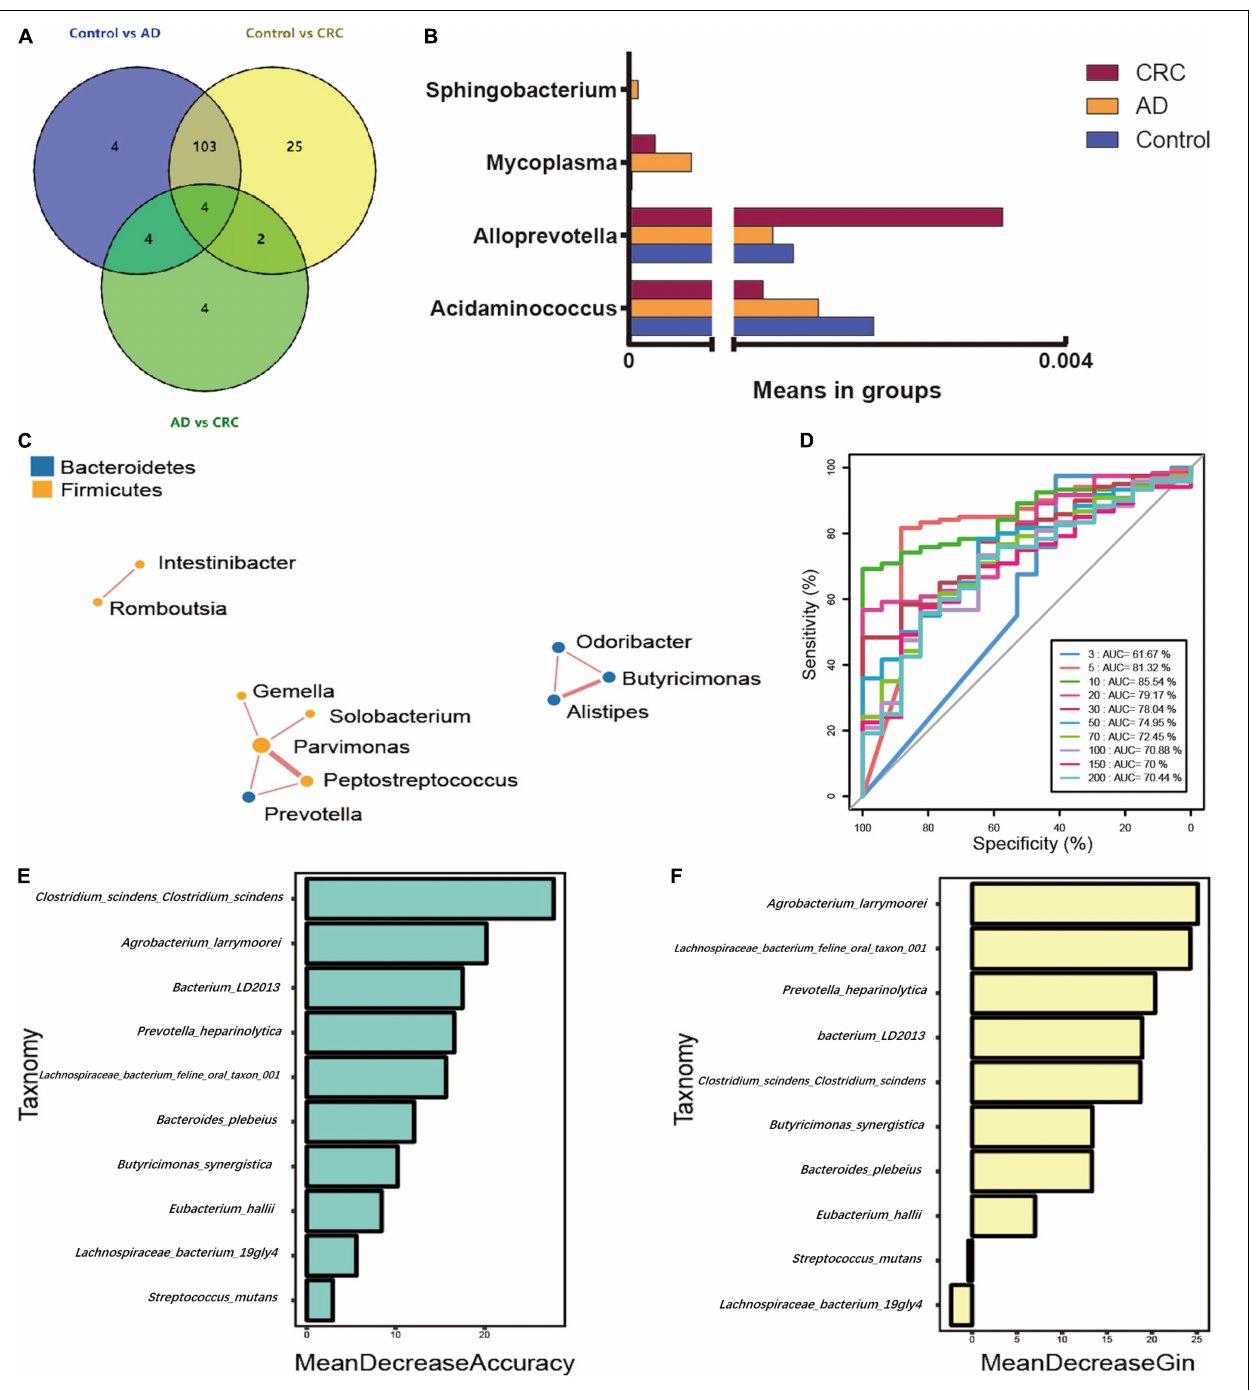
FIGURE 4 | (A) Venn diagram illustrating the total, unique, and shared number of significant pairwise difference at the genus level among the Control, AD, and CRC groups; (B) The relative abundance of the significant changed genera among the three groups; (C) Microbial association network for colorectal adenoma/carcinoma-associated genera; (D) Receiver operating curve (ROC) by Random Forest analysis for distinguishing AD patients from CRC; (E) Mean Decrease Accuracy (MDA) coefficients of the 10 most important species in distinguishing AD patients from CRC; (F) Mean Decrease Gini (MDG) coefficients of the 10 most important species in distinguishing patients with AD from patients with